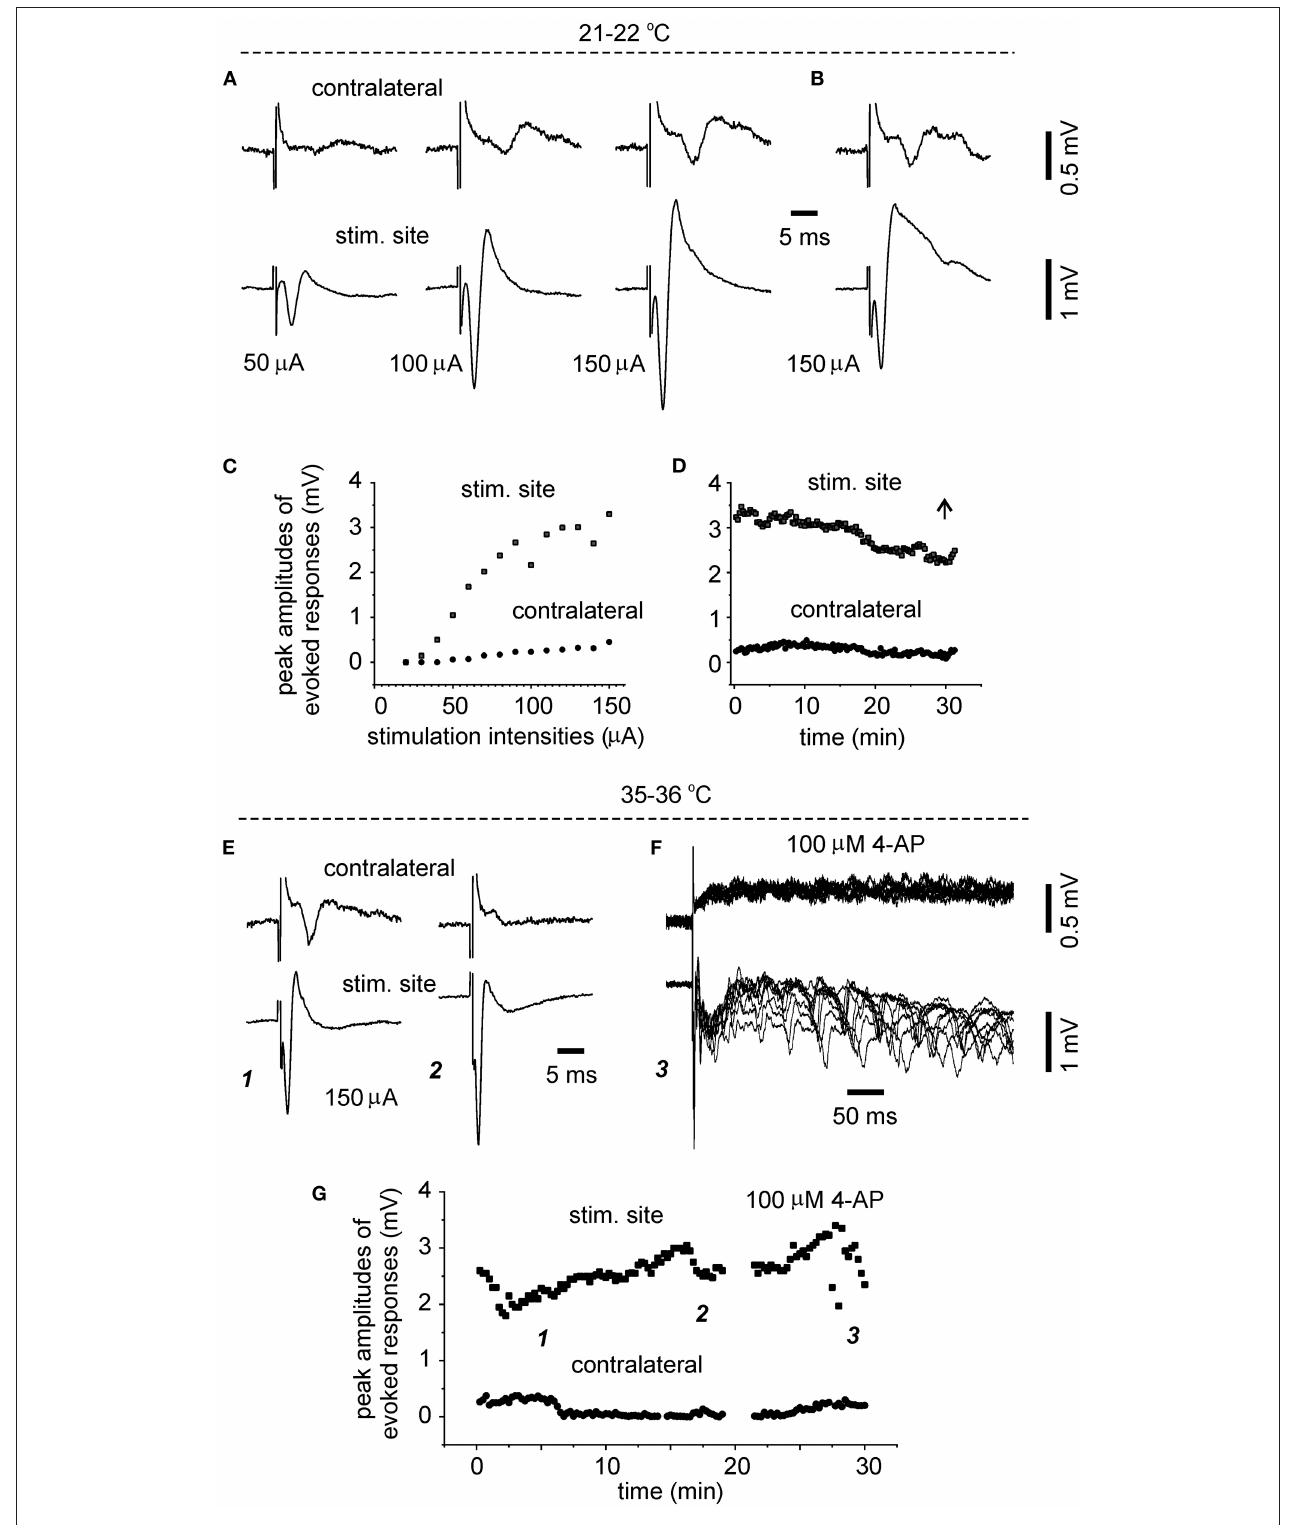
FIGURE 3 | Time- and temperature-dependent changes in evoked bilateral hippocampal responses. A bilateral hippocampal slice was obtained from a 29-day-old mouse. Unilaterally elicited and bilaterally recorded synaptic field potentials were collected initially at a room temperature [21–22 ◦ C, (A–D) ] and then at 35–36 ◦ C (E–G)